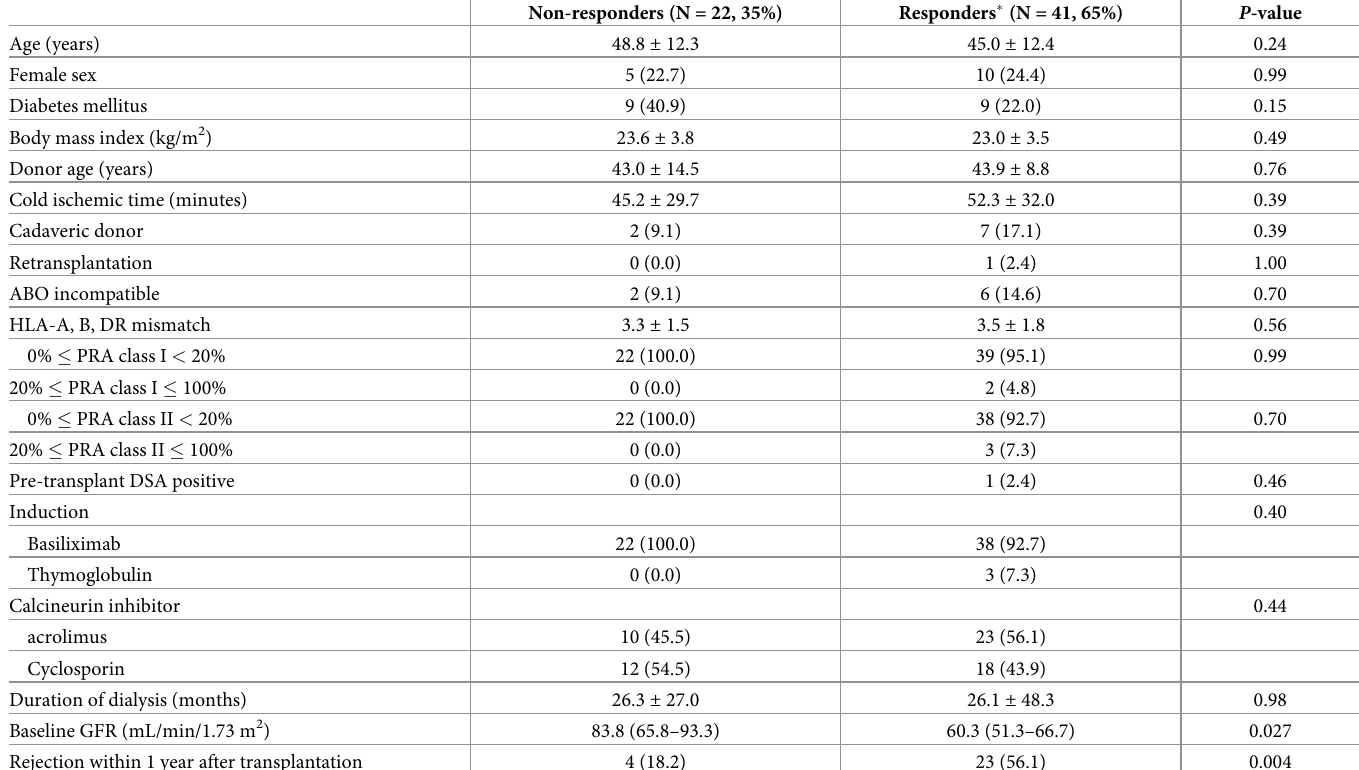
Table 1. Baseline and clinical characteristics of the study